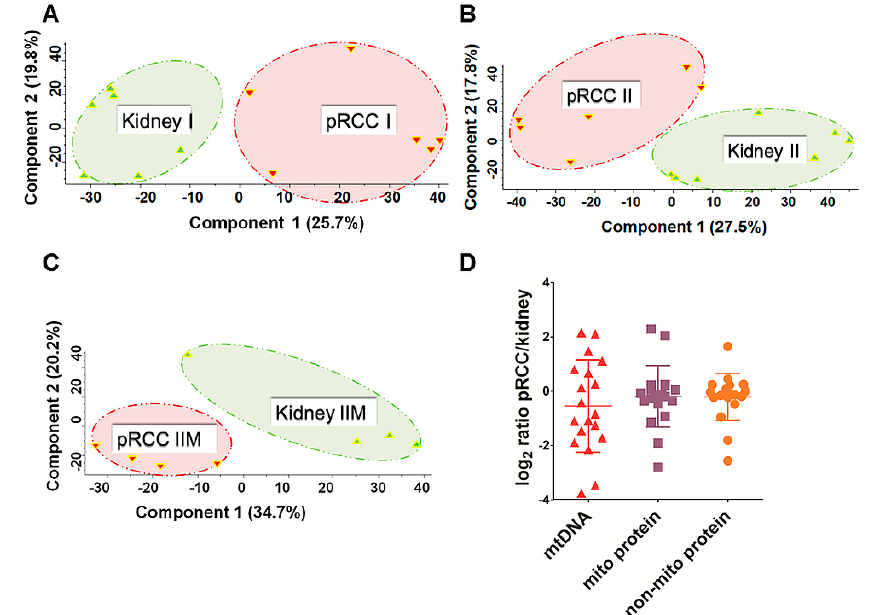
Figure 1 . Principal component analysis (PCA) and evaluation of the mitochondrial DNA (mtDNA) and mitochondrial protein content in papillary renal cell carcinoma (pRCC). PCA analysis in ( A ) pRCC type I ( n = 6), ( B ) pRCC type II ( n = 6), and ( C ) pRCC type IIM ( n = 4) revealed spatial separation for the proteome profiles. ( D ) Log 2 ratios of the mtDNA (mean − 0.55 ± 1.7 standard deviation (SD) based on whole-exome sequencing (WES) read depths, the mitochondrial- (mean − 0.19 ± 1.13 SD) and non-mitochondrial proteome ( − 0.22 ± 0.86 SD) in pRCC versus controls, ( n =